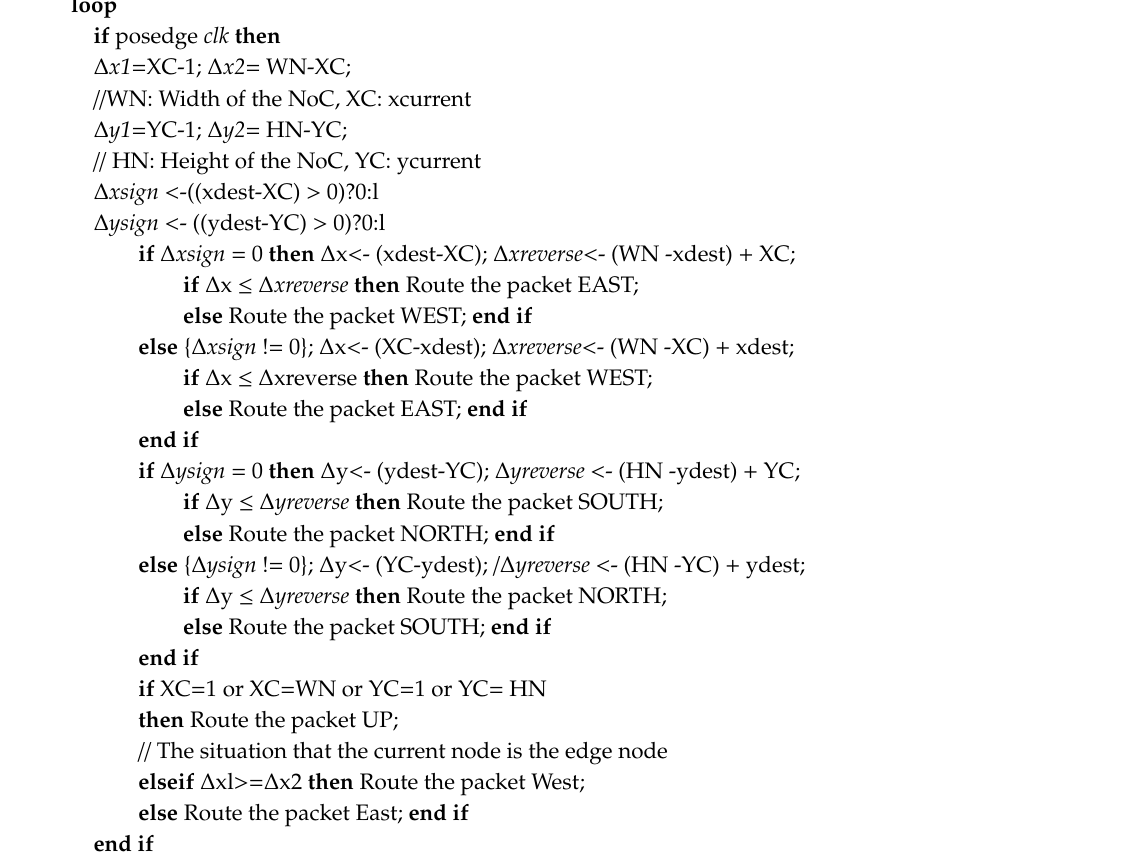
Algorithm 1: The HIP router for routing the packets in torus-based